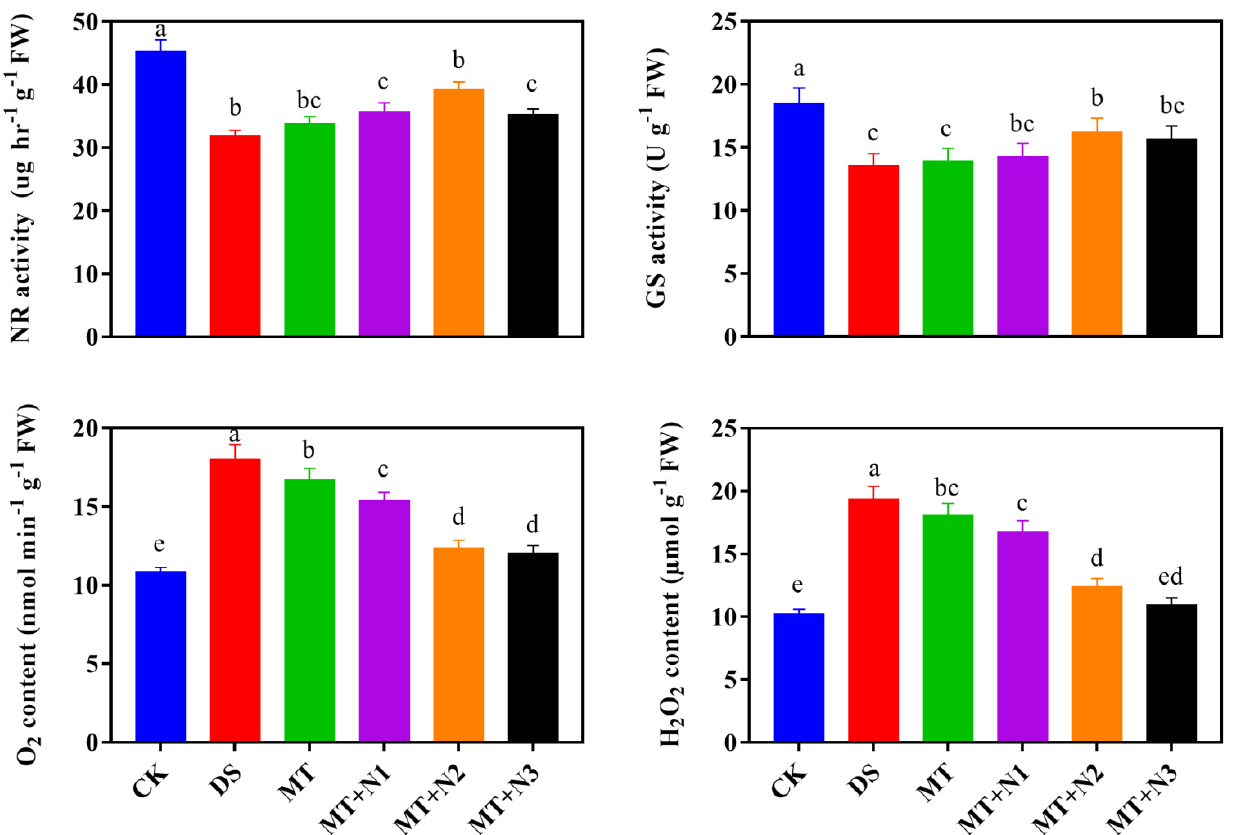
Figure 6. Nitrogen metabolism enzyme glutamine synthetase (GS), nitrate reductase (NR) activities, and reactive oxygen species (ROS) of maize seedlings under drought-stress conditions in combination with melatonin in different levels of nitrogen. CK; Well-watered control without melatonin (MT), DS; Drought stress without MT, MT; Drought stress + 100 µM MT, MT + N1; MT 100 µM + 200 kg N ha − 1 , MT + N2; MT-100 µM + 250 kg N ha − 1 , and MT + N3; MT-100 µM + 300 kg N ha − 1 . Vertical bars represent ± S.D. ( n = 3, biological replicates). Different letters indicate significant differences as determined by the LSD test ( p ≤ 0.05).